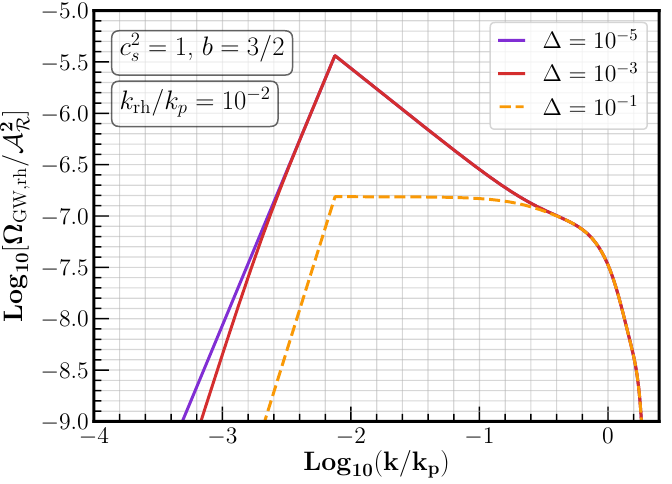
Figure 5. Induced GW spectral density for the log-normal primordial spectrum. We used c 2 s = 1, so there is no resonant peak. We also chose b = 3/2 ( w = 1/15) to show that for b < 1 the largest − k rh . In purple we show ∆ = 10 − 5 which peak of the induced GW spectrum for a Dirac delta is at k ∼ for the range of k shown in the plot is effectively the induced GW spectrum of a Dirac delta. For k < k rh the GW spectrum goes as k 2 . In red we show ∆ = 10 − 3 so that the effects of the finite width occur within the plot range. Around k / k p 5 10 − 2 the GW spectrum goes from k 2 to k 3 . Lastly, ∼ × we show in orange ∆ = 10 − 1 . The finite width becomes important now for k rh < k < k p and the GW spectrum transition from k 2 − 2 b = k − 1 to k 3 − 2 b = k 0